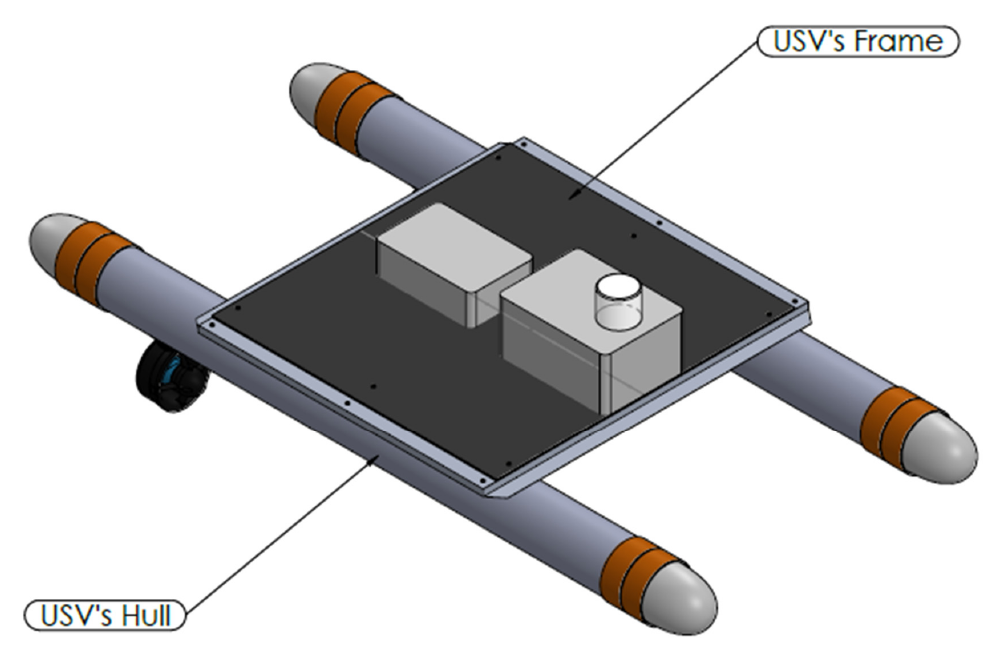
Figure 2. USV CAD